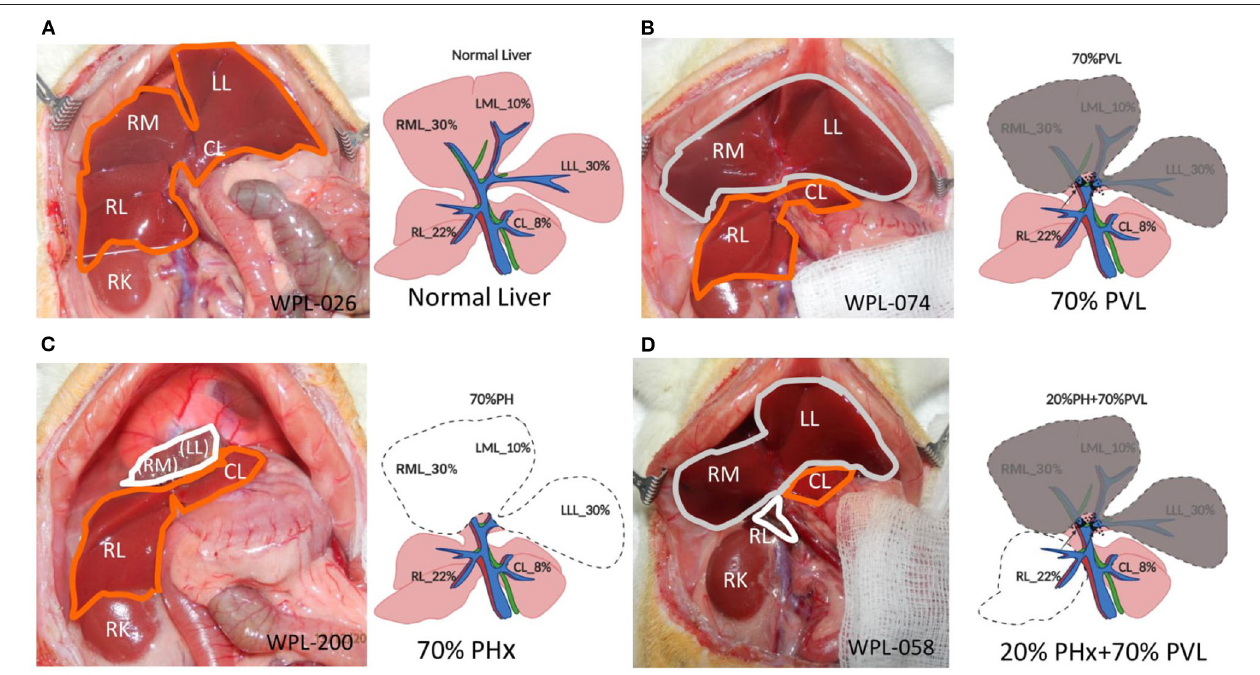
FIGURE 1 | Surgical procedures. (A) Open situs with liver (encircled in orange). (B) 70% portal vein ligation. Note the slightly darker color of the ligated median and left lateral lobe (encircled in gray) compared to the fresh color of the right and upper caudate lobe (encircled in orange) (C) 70% partial hepatectomy. Note the stump (encircled in white) above the right lobes (encircled in orange). (D) Combined 20% partial hepatectomy with 70% portal vein ligation: Note the dark color of the portally ligated median and left lateral lobe (encircled in gray), the fresh red color of the upper caudate lobe (encircled in orange) and the stumps from the right lobes (encircled in white). LLL left lateral lobe, ML median lobe, RL right lobe, Cl upper caudate lobe, RK right kidney, LLL, ML, and RL stumps of the respective